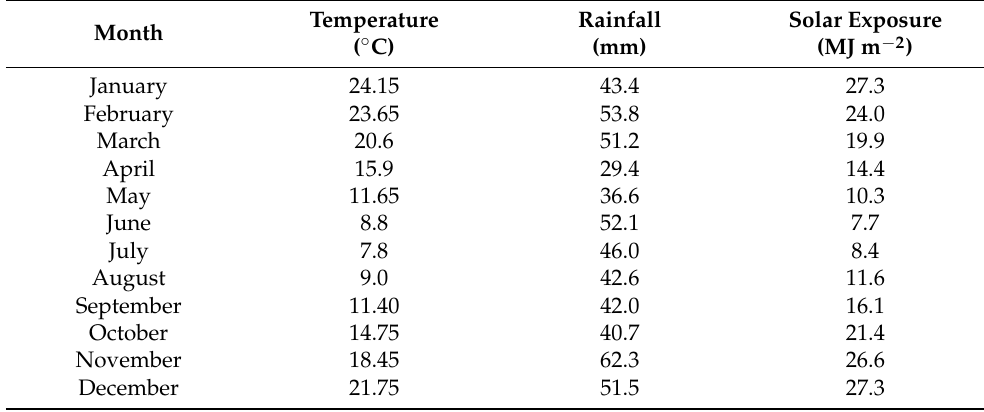
Table 2. Average (50 years) monthly temperature, rainfall, and solar exposure at WWAI.